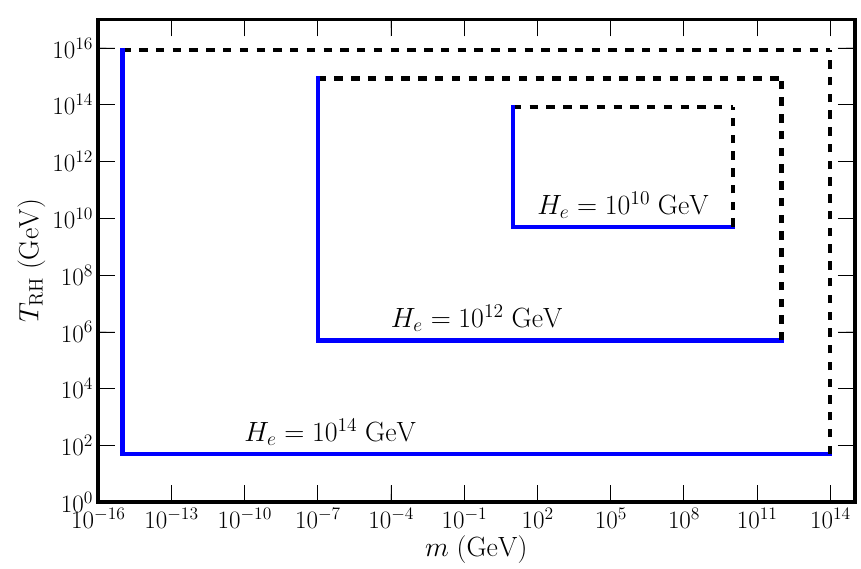
Figure 8 . The solid lines are the values of ( m, T RH ) that result in Ω h 2 = 0 . 12 for the indicated values of H e . The horizontal solid line is for late reheating while the vertical solid line is for early reheating. As mentioned in the discussion after eq. (6.3), if H e . 10 8 GeV there is no late-time reheating solution that results in Ω h 2 = 0 . 012 , while as discussed after eq. (6.4) if H e . 10 8 there is no early-reheating solution that gives Ω h 2 = 0 . 12 . The vertical dashed lines indicate m = H e ; GPP is suppressed for m > H e . The horizontal dashed lines indicate the maximum reheat temperature T MAX for a given H e allowed by energy conservation. Values of ( m, T RH ) inside the rectangles are RH forbidden since they would result in Ω h 2 > 0 . 12